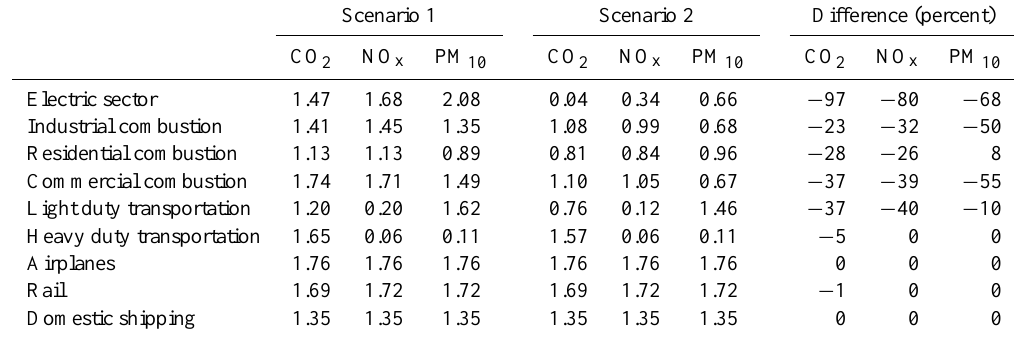
Table 3. EPA MARKAL Region 9 ∗ emissions growth factors, 2005 to 2050, for major energy system emission